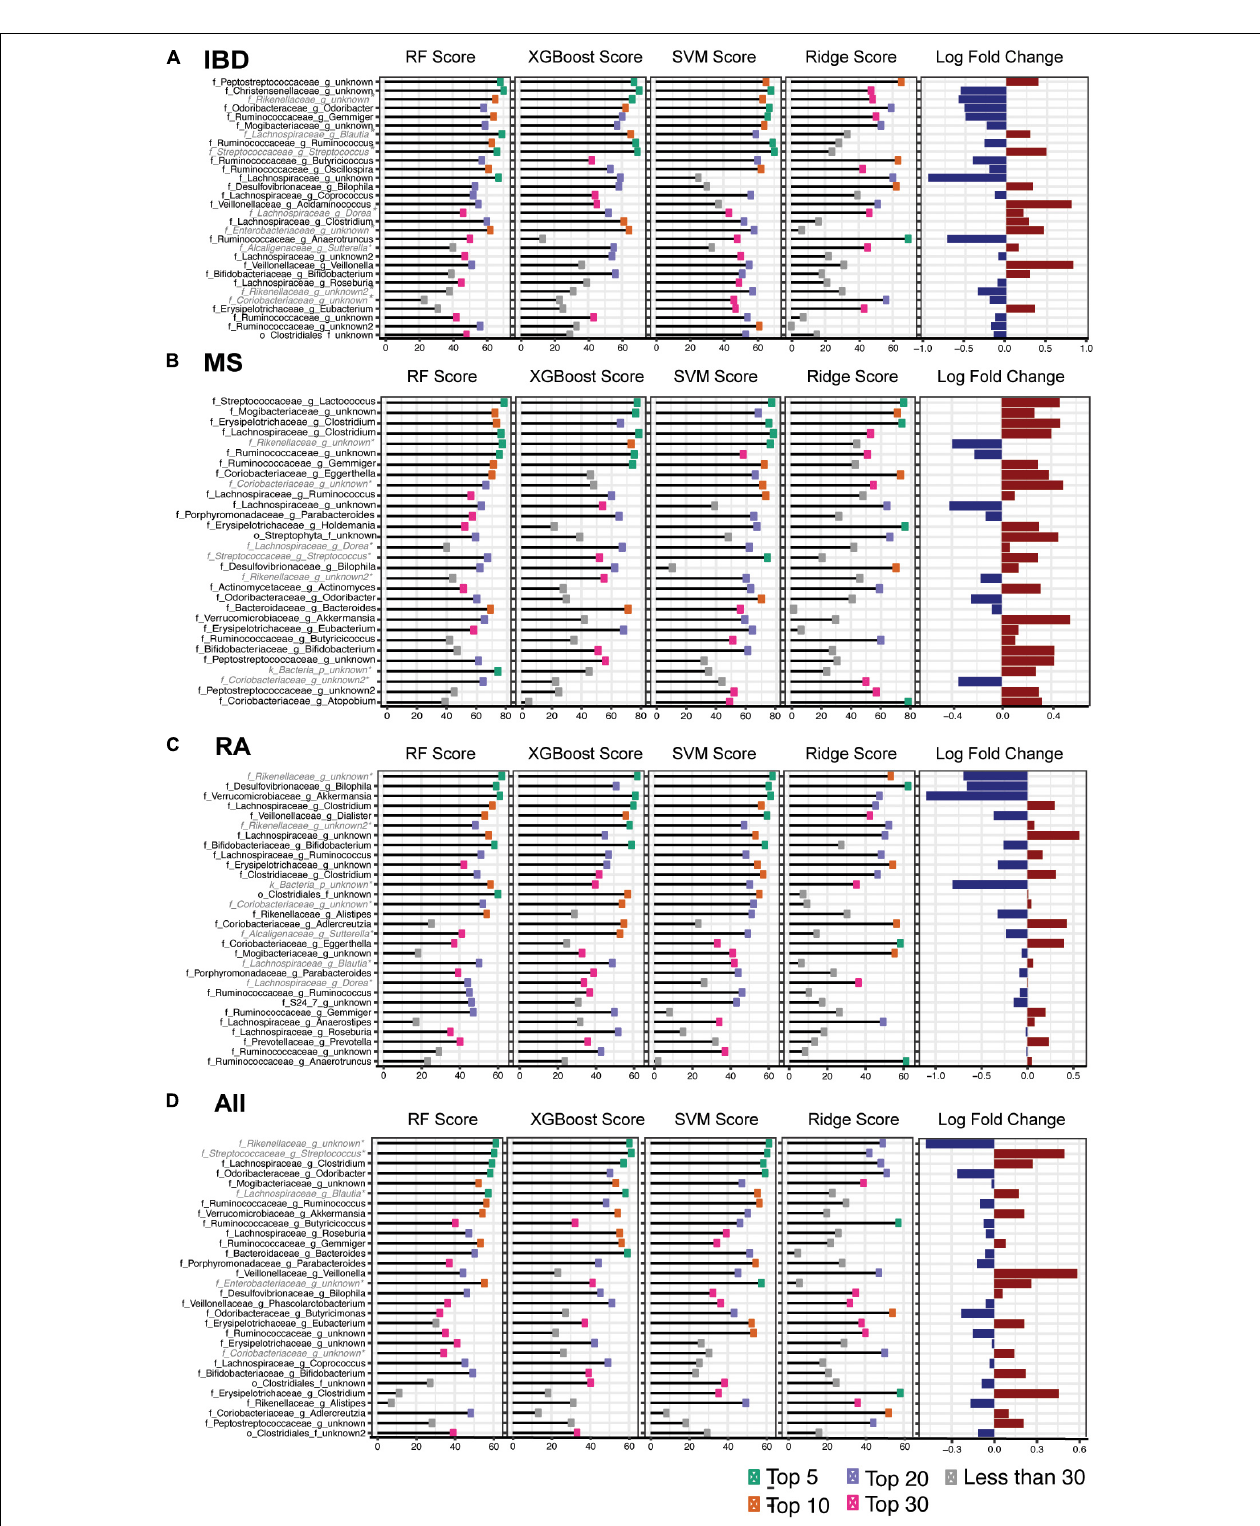
FIGURE 4 | Taxa Predictive of Disease Top 30 taxa across four predictive models (adults only), random forest (RF), XGBoost, and support vector machines (SVM), ridge regression for (A) inflammatory bowel disease (B) multiple sclerosis, (C) rheumatoid arthritis and (D) general autoimmunity. Features ranked by mean rank across the four models in descending order and color indicates the rank of each taxa in each model. Log fold change of disease vs. healthy for each taxon. *Indicates that the taxa highlighted was identified as being highly study specific ( Supplementary Figure 3 ).